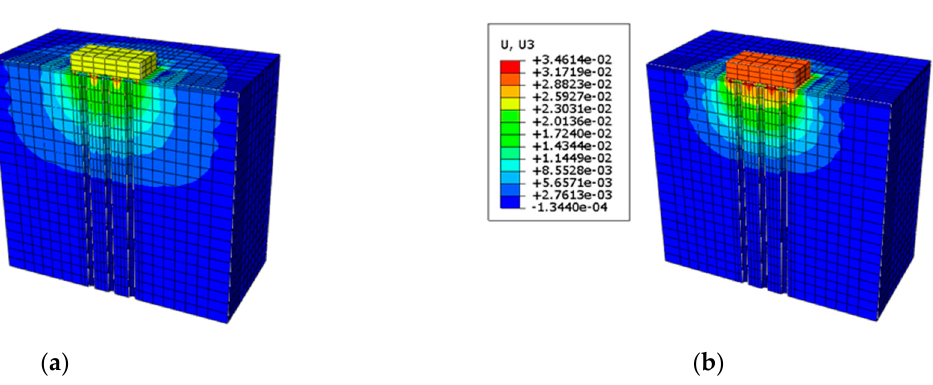
Figure 15. Settlement of a composite foundation(m): ( a ) Case 3; ( b ) Case 4.